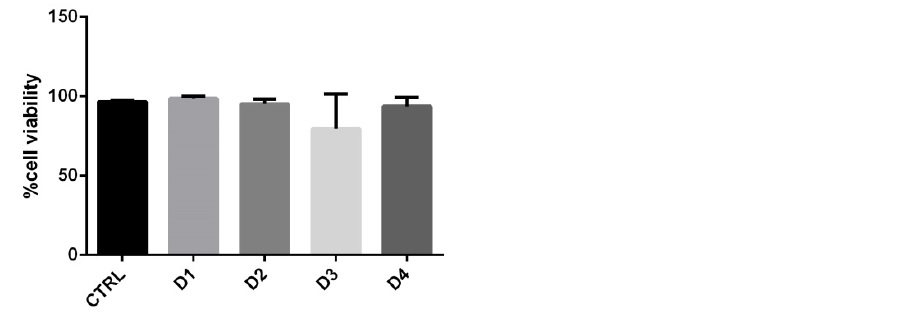
Figure 2. BFP-MSC viability on Ti disks. Percentage of live BFP-MSCs plated in 12-well culture plates without disks (CTRL), on disk D1, disk D2, disk D3 or D4 after 72 h.